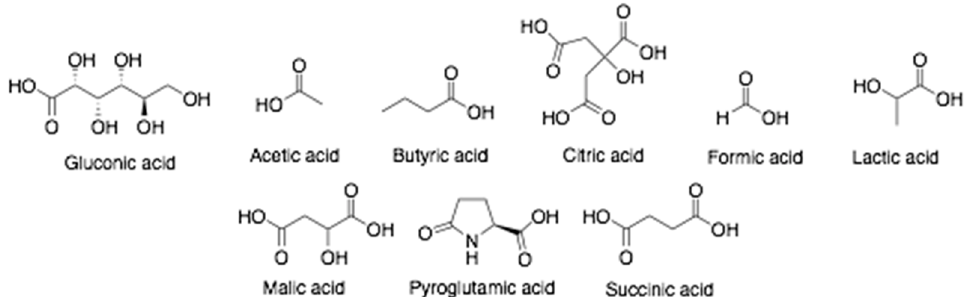
Figure 3. Chemical structures of organic acids found in honey.